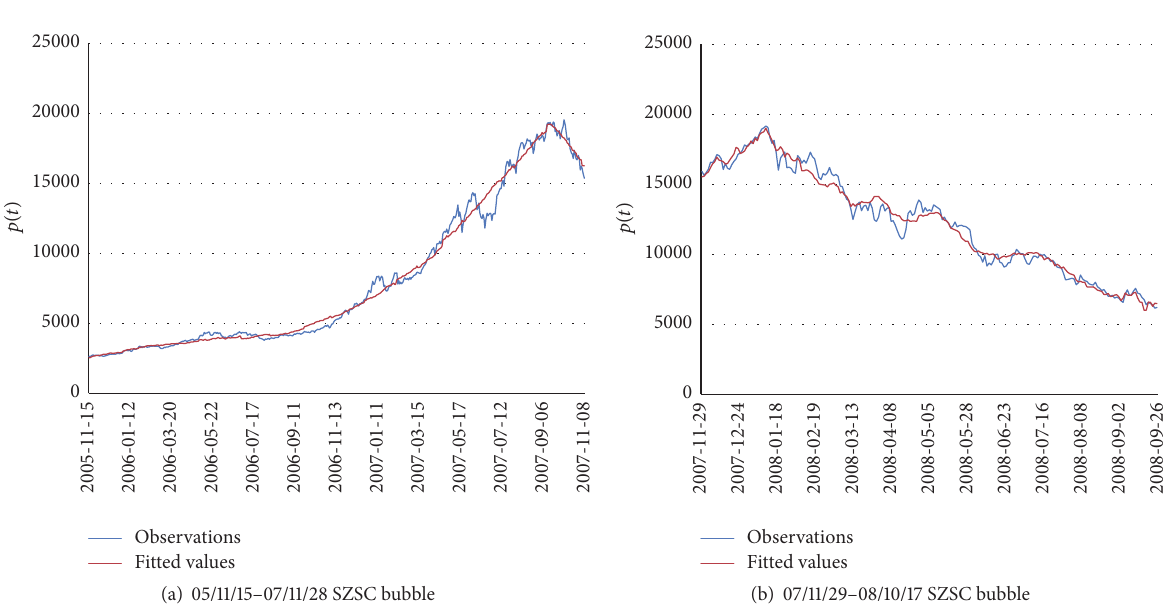
Figure 3: Daily trajectory of the SZSC from 2005/11/15 to 2008/10/17 by using the JLS-factor model presented in (10) with 𝑦(𝑡) = 𝑝(𝑡) . The fit of SZSC from 2005/11/15 to 2007/11/28 is illustrated in (a) as a red solid line, whose parameters are 𝑡 𝑐 = 2007/10/08, 𝜔 = 0.07, 𝑚 = 1.86, 𝜙 = 0.07, 𝐴 = 20506.38, 𝐵 = − 4784674.93, 𝐶 = 4780598.98, 𝛼 = − 183.50, 𝛽 = − 296.39, 𝜑 = 118.94, and 𝛾 = 1.87 with an r.m.s. of the fit residuals 𝜒 = 523.35. The fit of SZSC from 2007/11/29 to 2008/10/17 is illustrated in (b) as a red solid line, whose parameters are 𝑡 𝑐 = 2008/01/15, 𝜔 = 14.85, 𝑚 = 0.53, 𝜙 = 2.82, 𝐴 = 12998.06, 𝐵 = − 12652.93, 𝐶 = 1164.16, 𝛼 = 861.36, 𝛽 = − 275.90, 𝜑 = 101.22, and 𝛾 = 4.89 with an r.m.s. of the fit residuals 𝜒 =